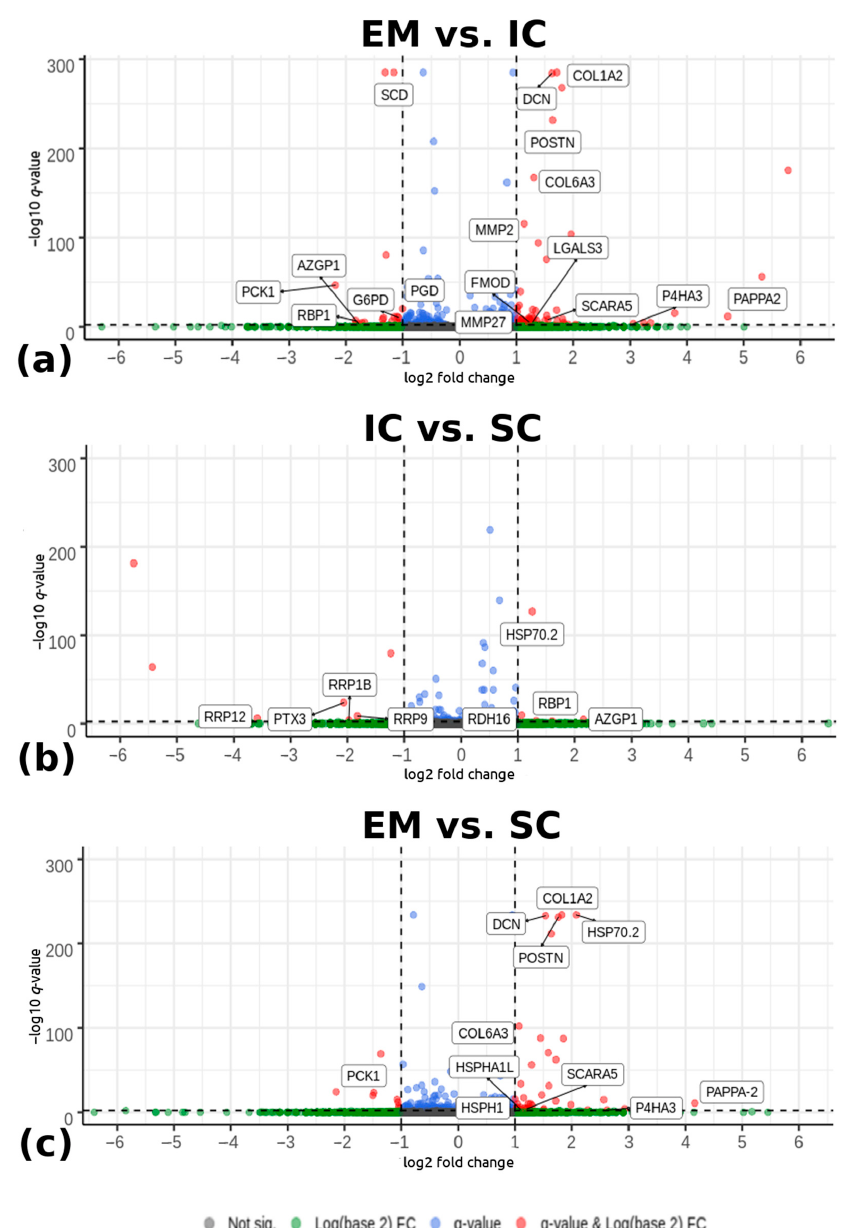
Figure 1. Volcano plots depicting genes expressed in the backfat tissue from pigs according to male sex category: ( a ) EM and IC, ( b ) IC and SC, and ( c ) EM and SC pigs. The horizontal lines indicate the significance threshold of differentially expressed genes at ‐ log 10 ( q ‐ value) < 0.005. The vertical lines represent the threshold of |log 2 (fold change) > 1|. Red dots represent upregulated and downregulated differentially expressed genes with |log 2 (fold change) > 1| and ‐ log 10 ( q ‐ value) < 0.005. Genes (dots) that are labelled are the most important genes which were identified and discussed in the Discussion chapter. Blue and green dots are representing the remaining detected genes that did not meet the determined criteria. EM = entire males; IC = immunocastrated pigs; SC = surgically castrated pigs; FC = fold change.